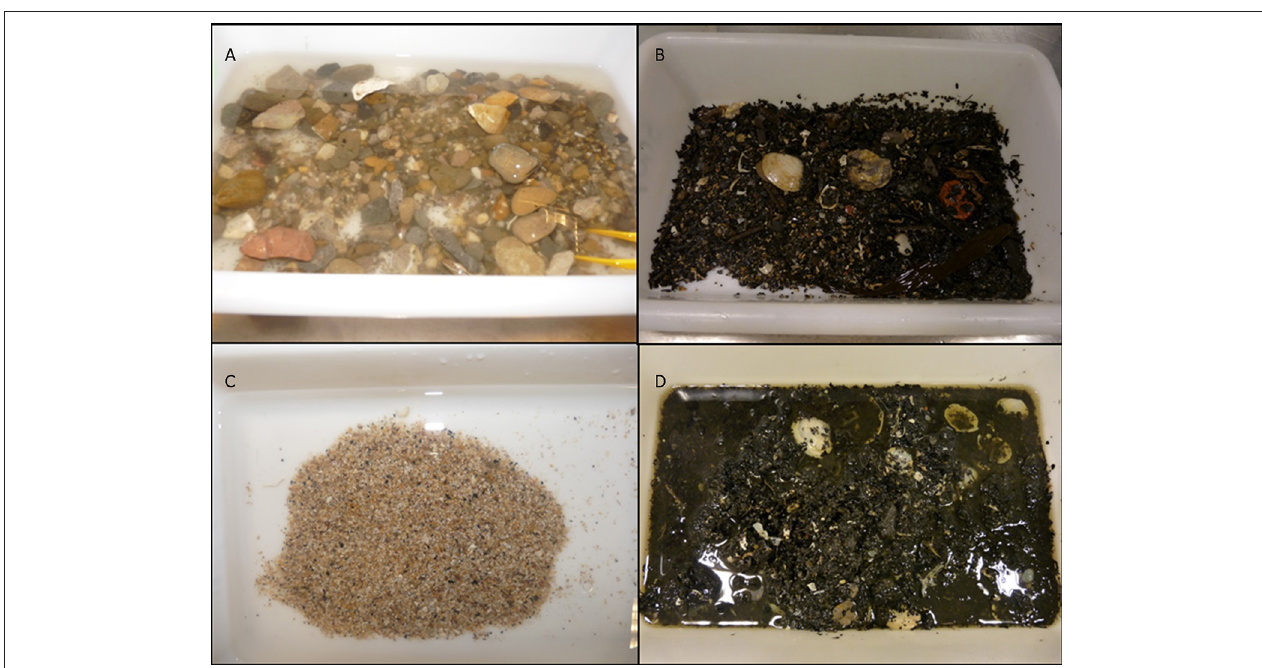
FIGURE 1 | Different types of sediment samples collected from intertidal and sublittoral benthic environments. (A) Coarse Sands, (B) Medium Sands, (C) Fine Sands and (D)